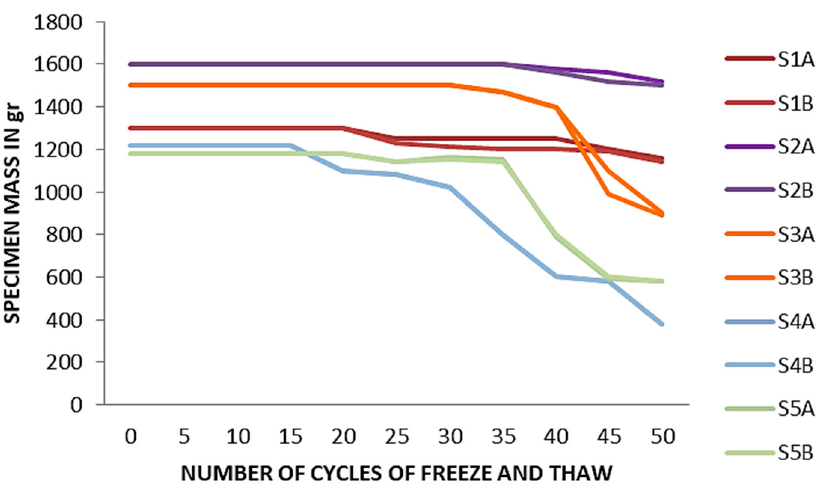
Figure 8. Diagram of the behavior of different concrete specimens under freeze–thaw conditions.